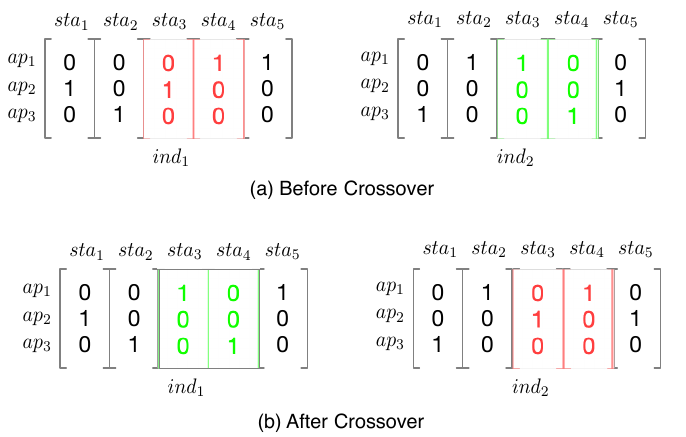
Figure 6. Crossover process. ind 1 and ind 2 are two input individuals, which are transformed by the crossover function. Here, sta 3 and sta 4 are chosen at random to be swapped during crossover to create new individuals.